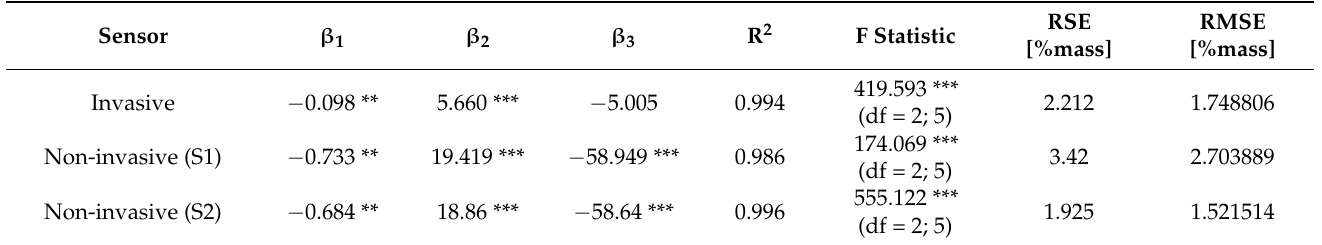
Table 7. Estimator values of the adopted calibration models for the measuring probes used (400 c.c. sample).